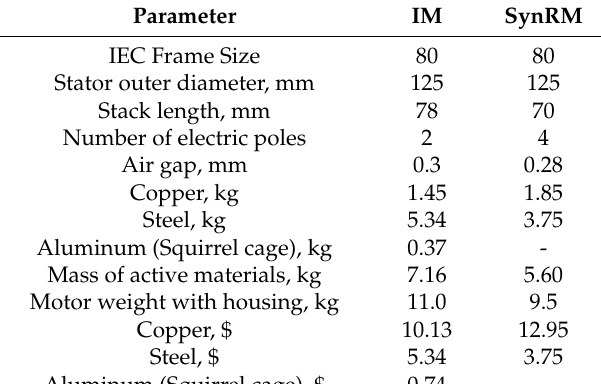
Table 1. Specifications of the 1.1 kW NM 40/12F/A Pump at the rated speed of 2900 rpm.